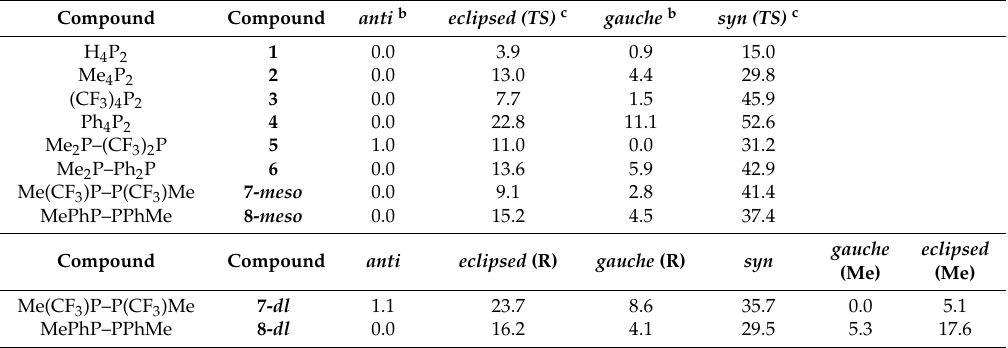
Table 2. Gibbs free energies, ( ∆ G ) in kJ · mol − 1 of compounds 1 – 8 in various conformations a